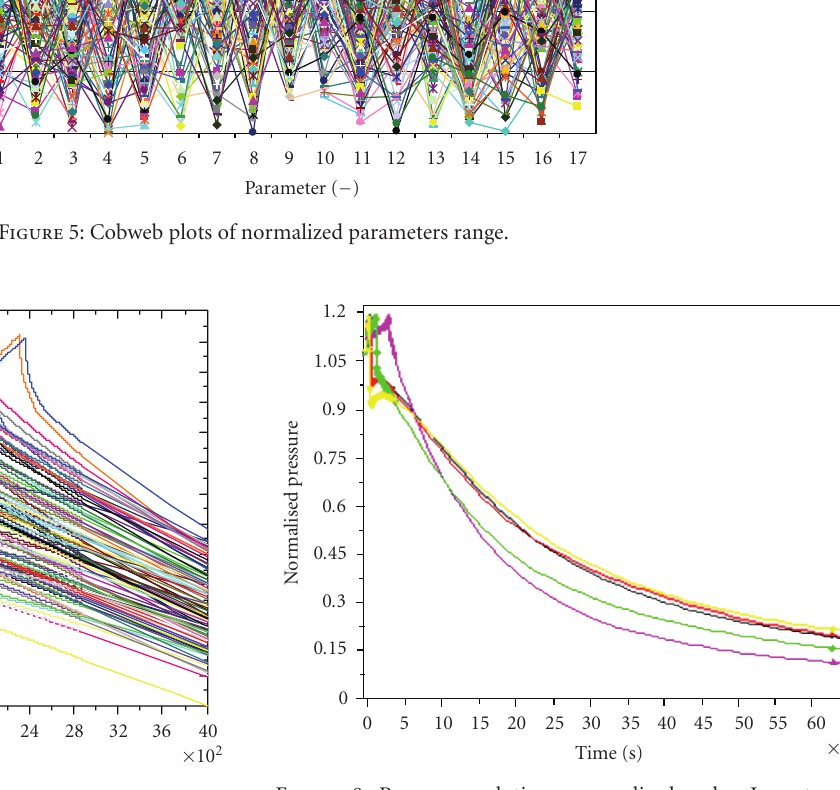
Figure 6: Pressure behavior—normalized scale—Short-term (stochastic selected and nominal case).